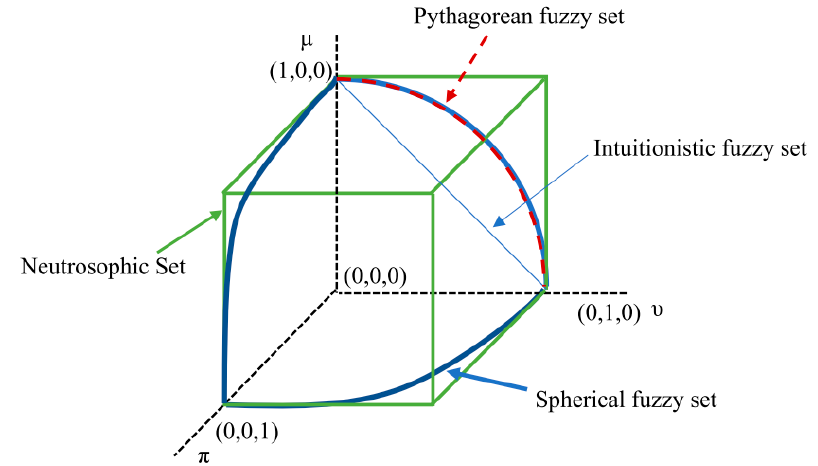
Figure 3. Geometric representations of SFS in a 3D plane.